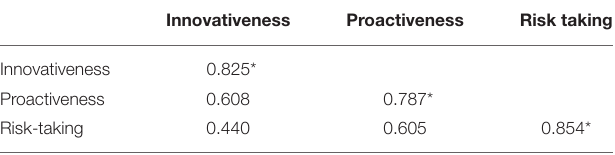
TABLE 3 | Discriminant validity of entrepreneurial orientation.